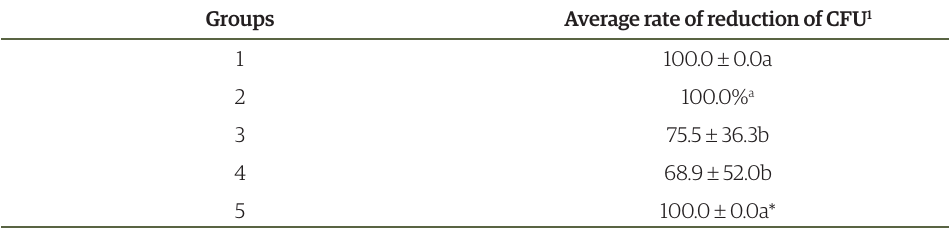
Table 2. Comparison between the reduction rates of UFC accessories in the